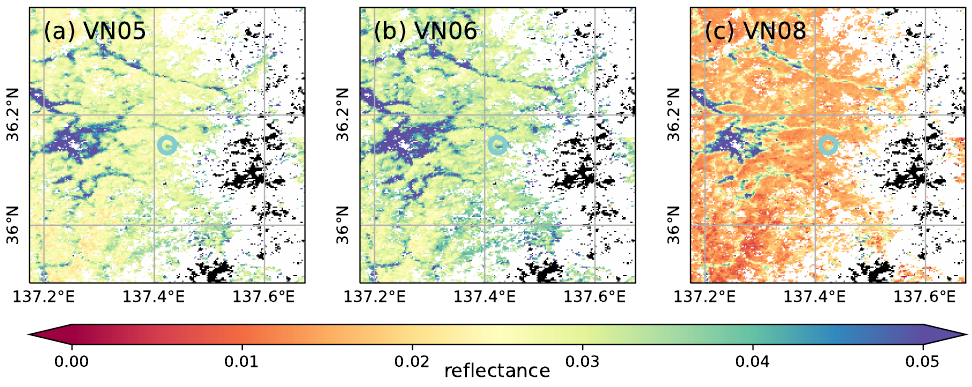
Figure 15. The spatial distribution of ( a ) VN 05 satellite , ( b ) VN 06 satellite , and ( c ) VN 08 satellite on 2 August 2019 (DOY = 214) around TKY. The range of each map is the same as that of Figure 14b–d. All maps are screened with the QA flag. The cyan circles in each figure indicate the location of